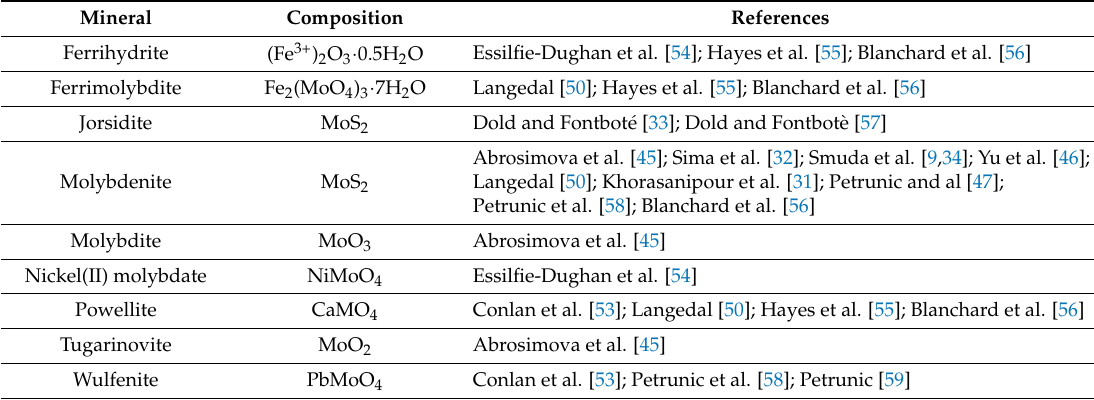
Table 5. Mo-bearing minerals in mine